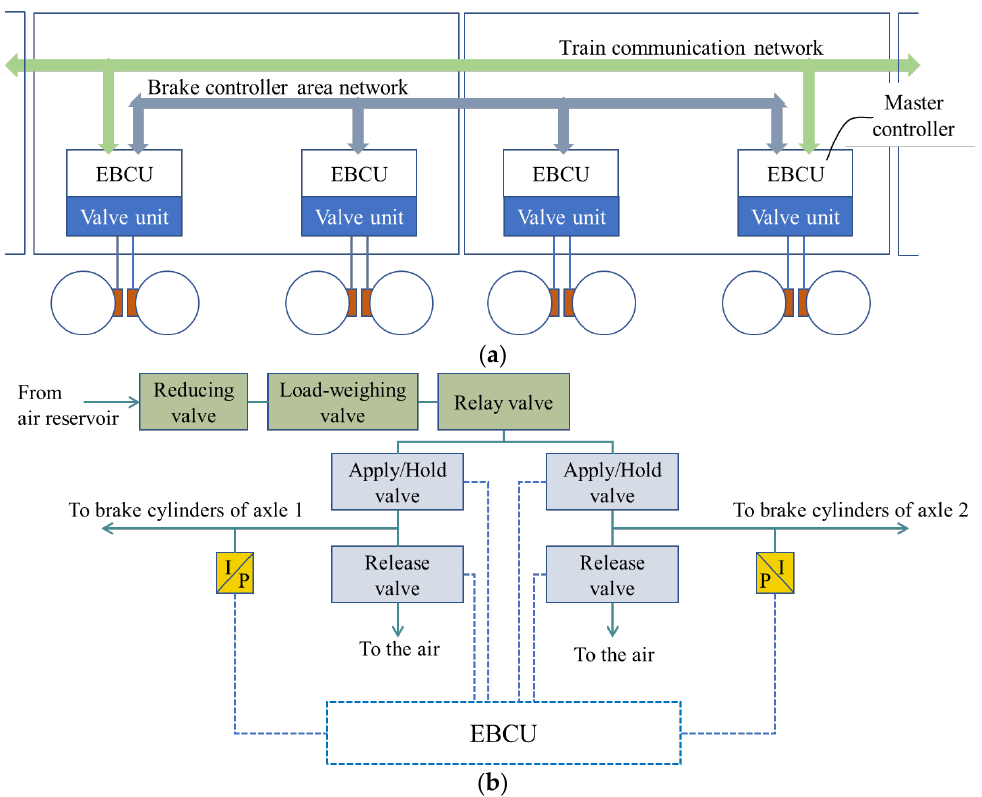
Figure 1. Architecture of the bogie-controlled braking system: ( a ) communication architecture; ( b ) working valves diagram.